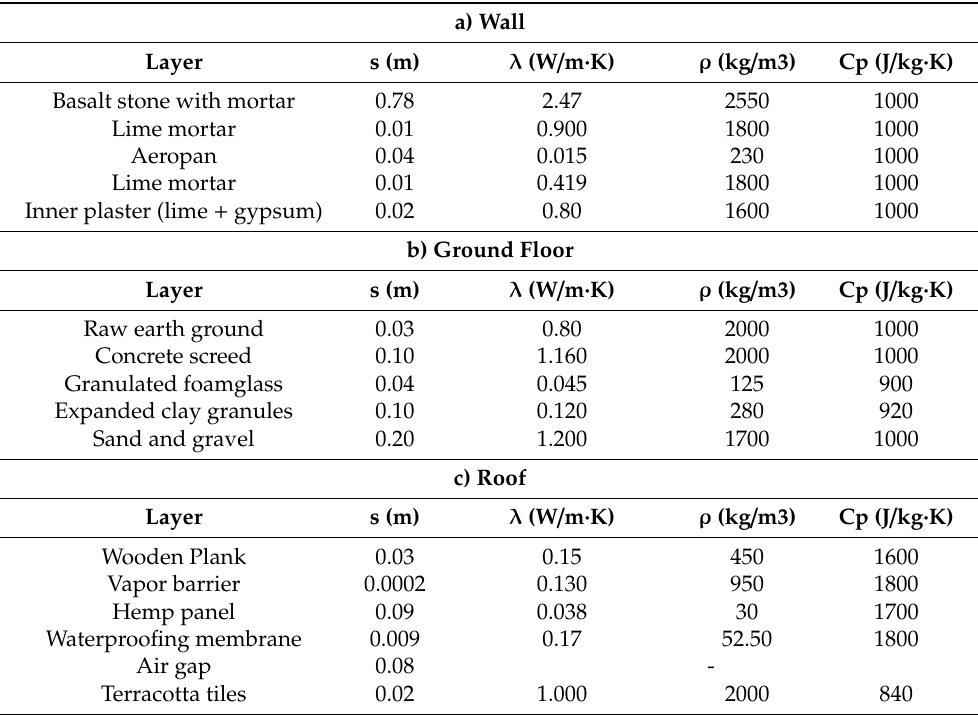
Table 4. Thermophysical properties for each layer that composes opaque and glazing components after retrofit.